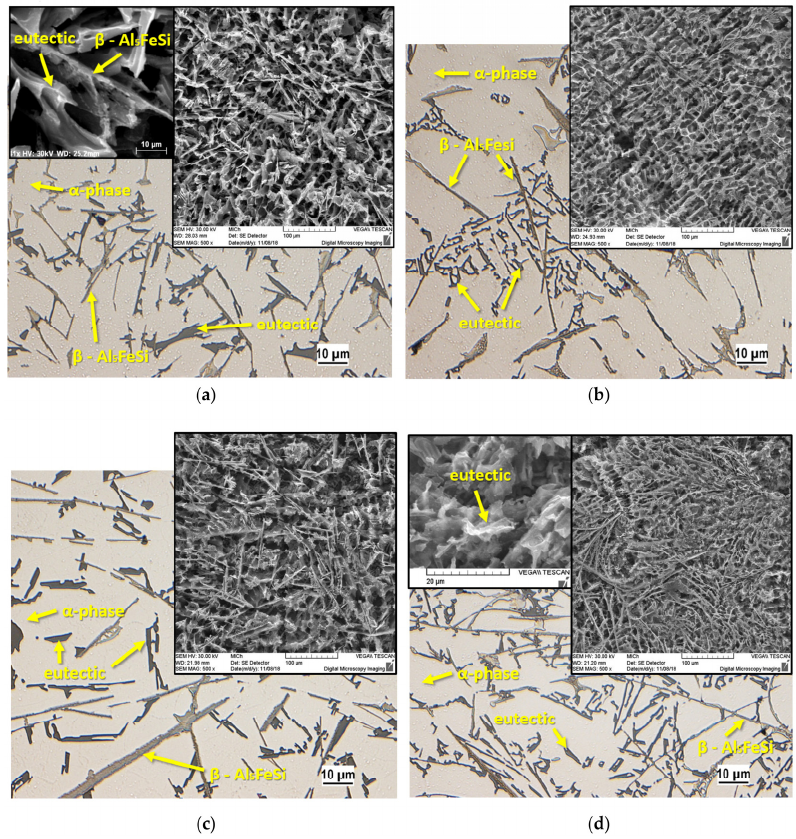
Figure 1. Microstructures of the AlSi9Cu alloy after: ( a ) one cycle of remelting, ( b ) three cycles of remelting, ( c ) five cycles of remelting, and ( d ) seven cycles of remelting [27]. One of the main sources of scraps used in the production of SAAs is returnable ma- terial, which consists of cast-off pieces such as gating, riser, and venting systems. It is common in the sector to fuse primary alloys with these recovered materials to reduce pro- duction costs. However, the quality of the casting tends to decline as the proportion of returnable materials rises caused by contaminations such as oxides and hydrogen that lead to an increase in porosities and other defects. Matejka et al. [28] demonstrated that the microstructure of the HPDC AlSi9Cu3(Fe) alloy was primarily affected by the coars- ening of Si particles, particularly in the center area of the casting when returnable material usage was greater than 75%. These authors revealed that, in the as-cast state, no significant impact on porosity levels was observed, but the application of heat treatment provoked an increase in the pore size. In a different study [29], the hot tearing index and other qual- itative and quantitative measurements were used to examine the susceptibility to hot tear- ing. The permissible sensitivity limits for this defect were achieved when the returnable material fraction reached 50% of the bath. Even a 20% returnable material fraction had a negative effect. The researchers reached the conclusion that, in order to maintain high- quality castings, the ideal utilization of returnable material percentage should be about 50%. Usages above 50% of returnable material might be troublesome and are only advised